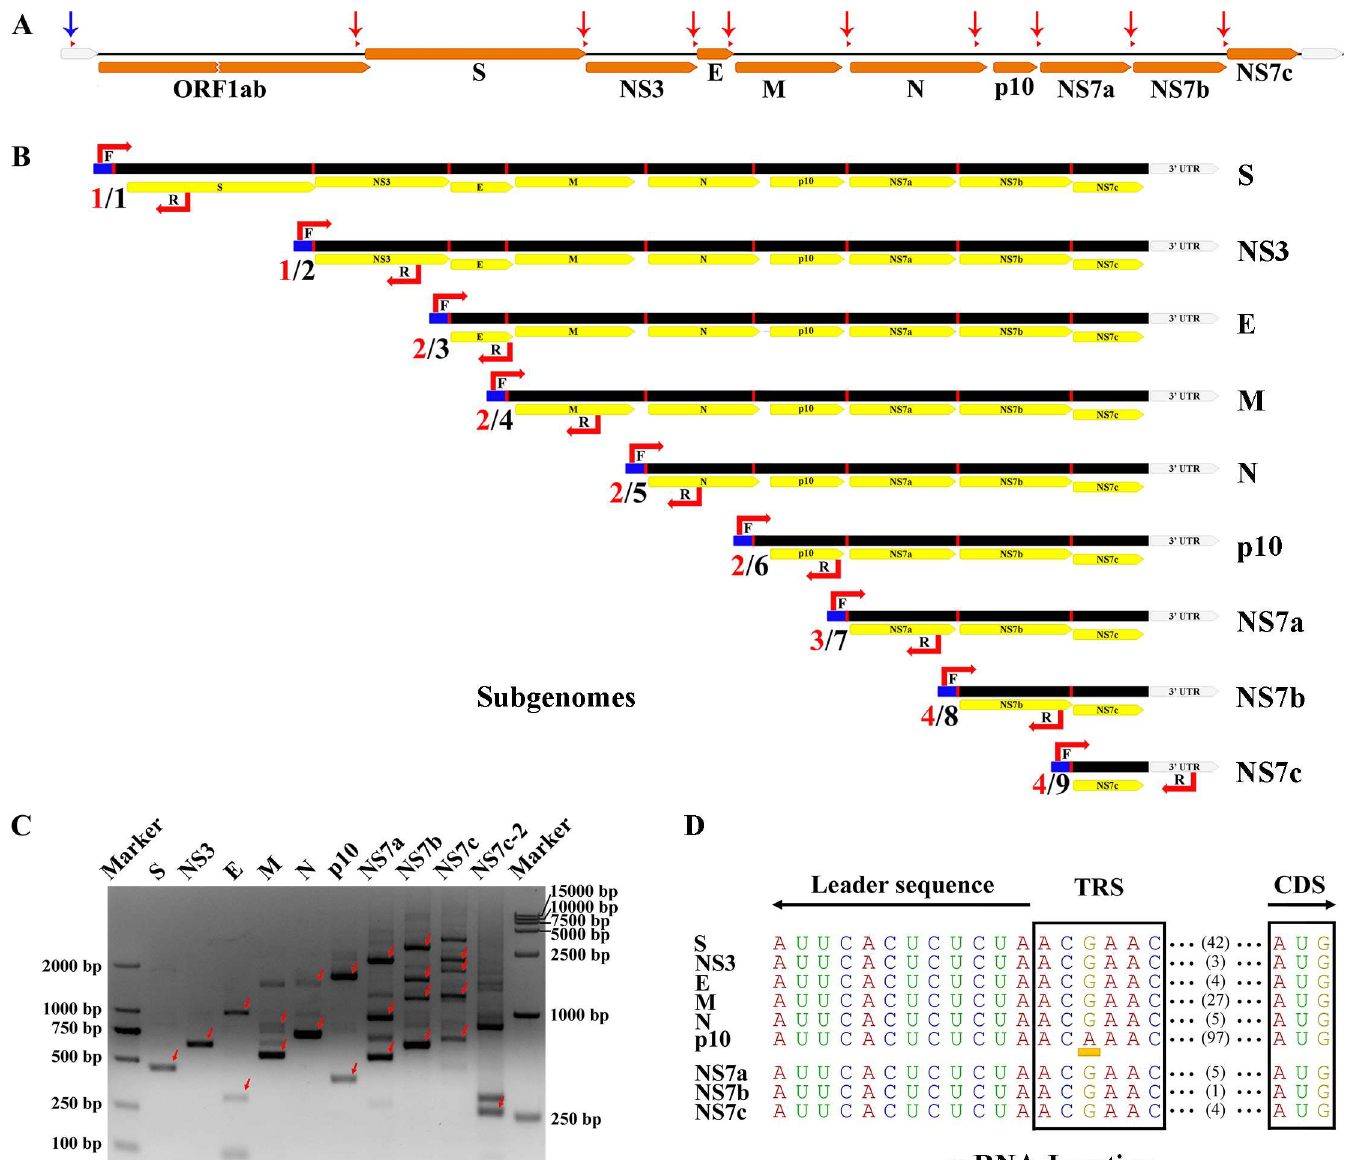
Fig 6. Subgenomic structures of Ro-BatCoV GCCDC1. (A) Schematic of the Ro-BatCoV GCCDC1genome.The genomeis representedby a black line; ORFs, and the 5’-UTRand 3’-UTRsare indicated by yellow and grey arrows, respectively. The TRSs are markedwith small red triangles.The genomic locations of the leaderand body TRS(s)are shown with blue and red arrows, respectively. (B) Schematicstructures of putative transcribedsubgenomic mRNAs. Subgenomes are representedby a black rectanglesand the commonleadersequenceis denotedby a blue box. The targetsites of forward and reverse primersare markedand indicated with letterF and R, respectively. Two numbersare shown in frontof each subgenomic mRNA.The black number to the rightof the slash indicates the potentialnumberof fragment(s) that could be amplifiedusing this set of primers,while the red one to the left represents the actual numbers of the fragment(s) obtainedin this experimentwhich corresponds to the numberof band(s)on each lane markedwith a red arrow(s)on the agarosegel. (C) Agarosegel electrophoresis of the PCR productsof subgenomic mRNA.The lowest band markedwith a red arrow on each lane is the specific amplicon of each subgenomic mRNA.Othermarked bands are amplicons of uppersubgenomicmRNAs as shown in Fig 6B. (D) mRNA junctions of the detectedsubgenomic mRNAs. The TRSs and fusion sites are shown in a black frame. The bias of the TRS of p10 gene is highlighted with a yellow block. The leadersequenceand CDS are indicated.The lengthsof intergenic sequences are shown with numbers. contains a p10 protein located at the 3’-end of the genome that appears to have captured from a bat-origin orthoreovirus by heterologous recombination.